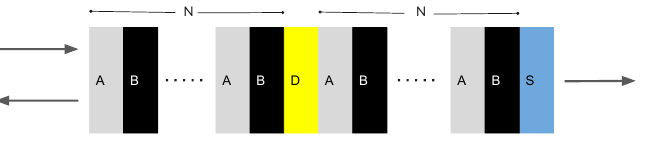
Figure 1. Schematic diagram of one-dimensional defective photonic crystal of asymmetric geometry ( AB ) N D ( AB ) N S